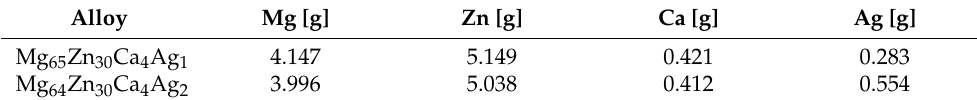
Table 1. Chemical composition (atomic and weight concentration) of alloys (powder weight = 10 g). Alloy Mg [g]